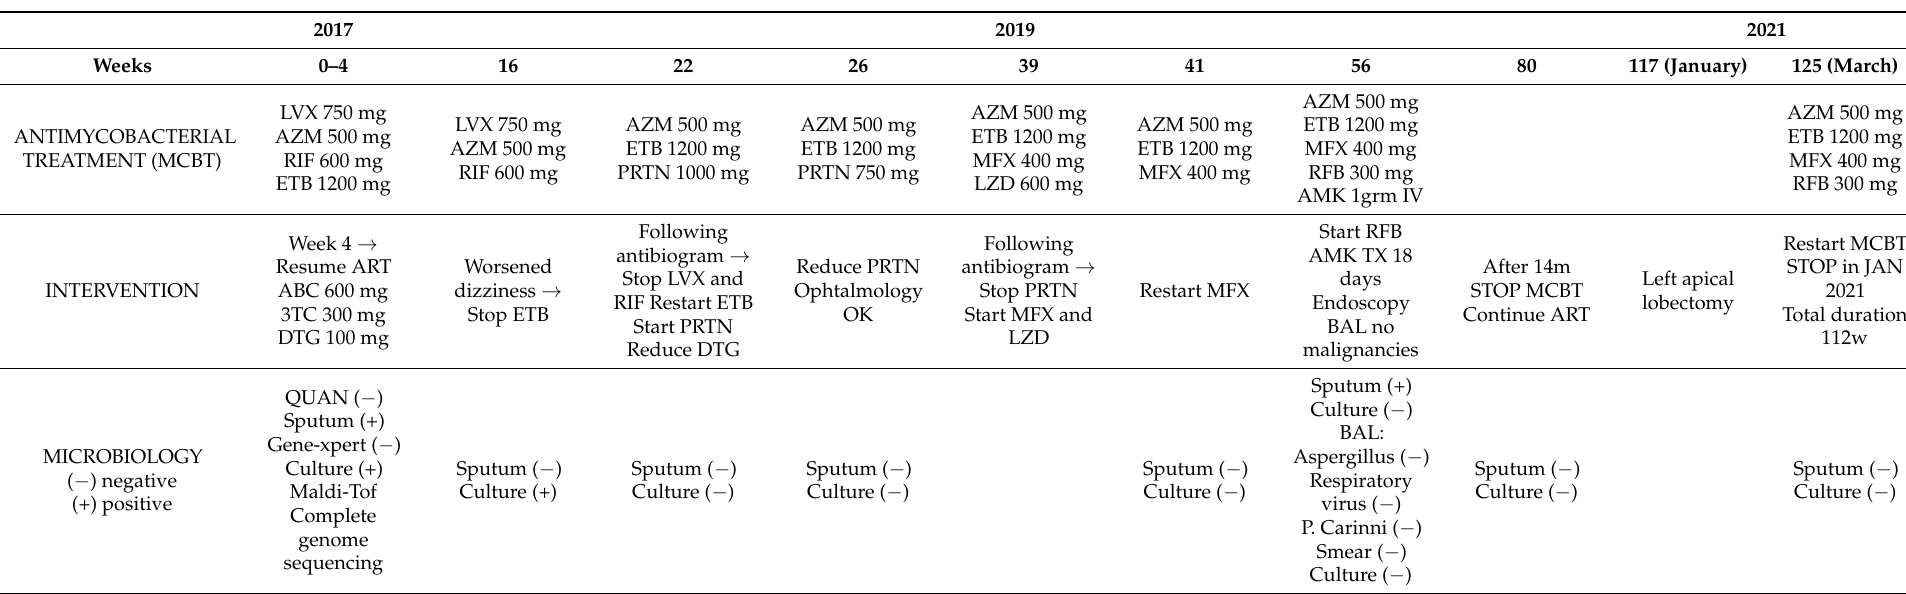
Table 1. Treatment prescriptions and